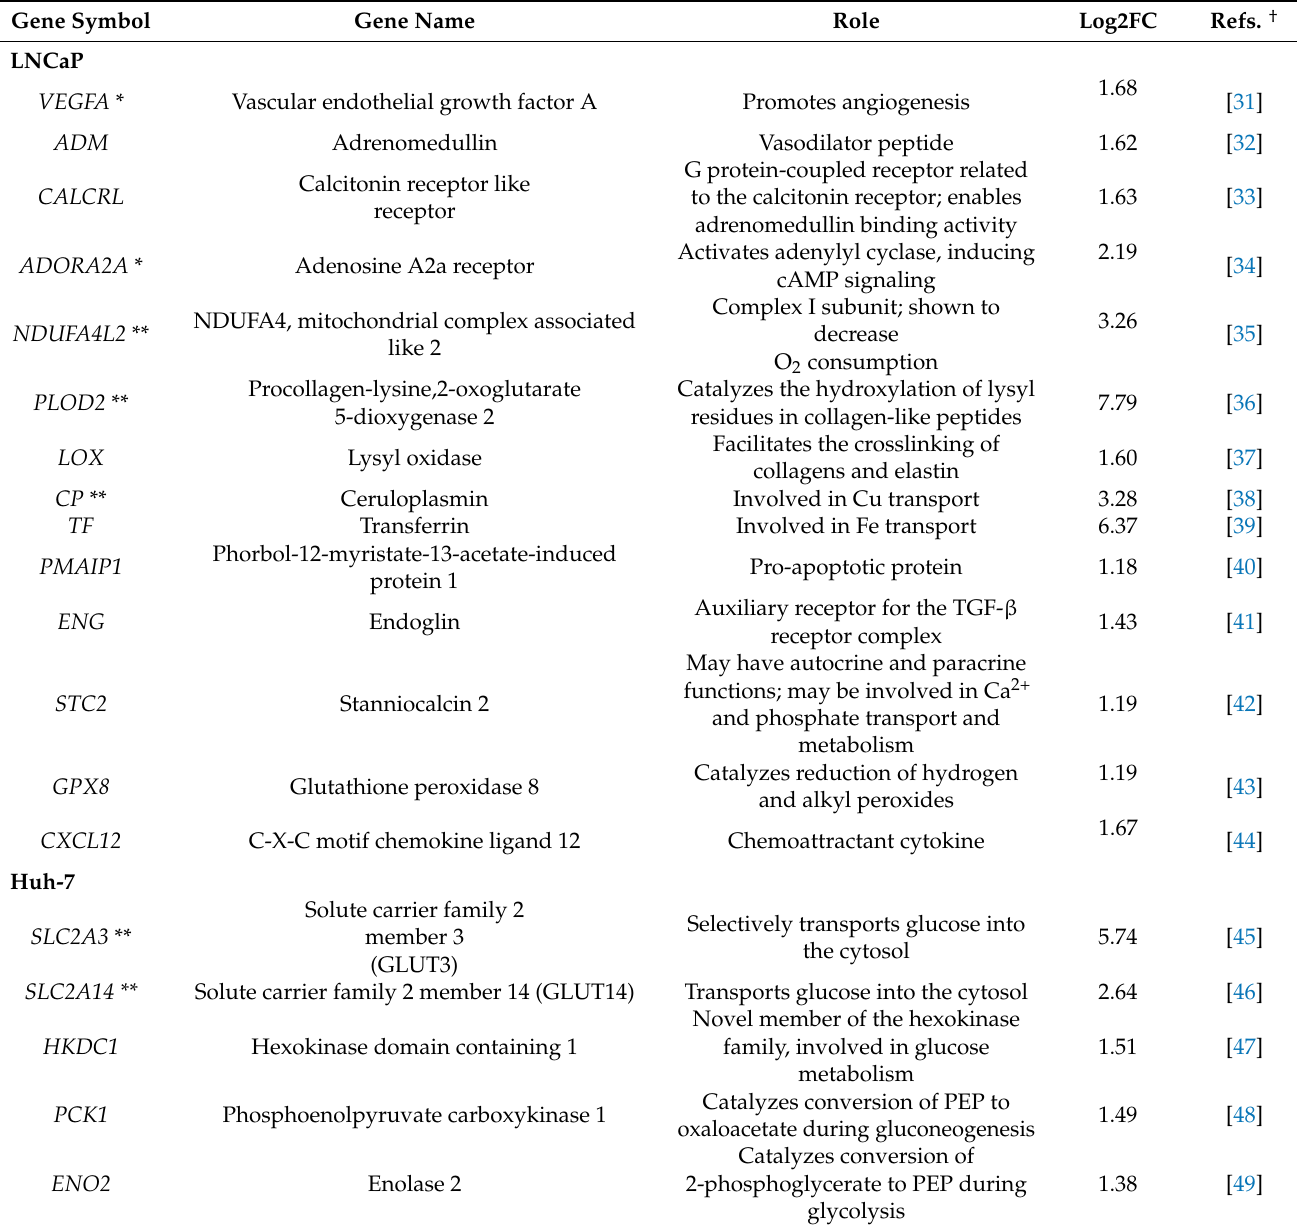
Table 3. Selection of differentially expressed HIF-1/2 targets upregulated at 5% O 2